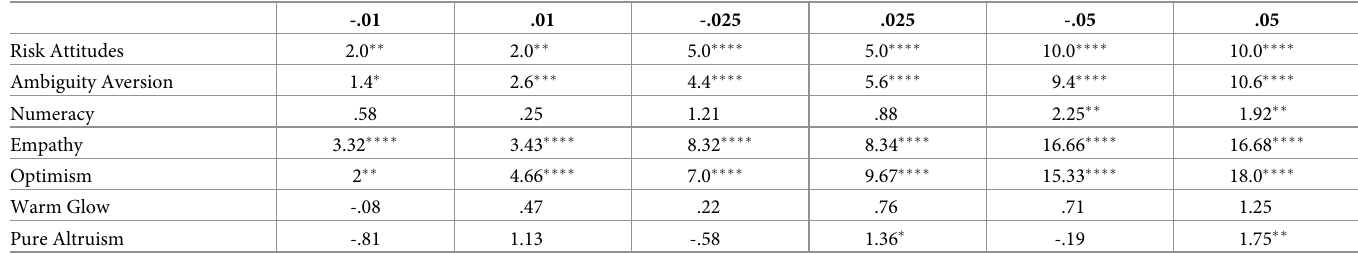
Table 5. TOST for main choice coefficients.